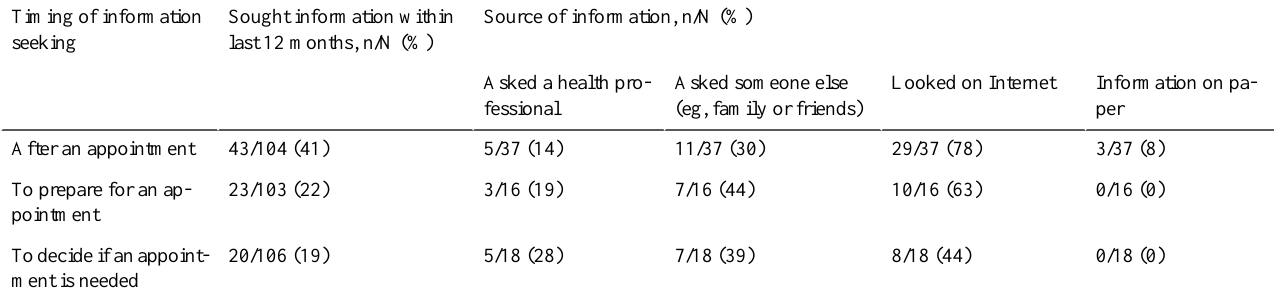
Source of information, n/N (%)Sought information within